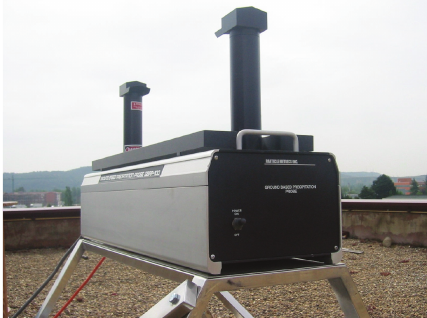
Figure 1: Ground-Based Precipitation Probe (PMI Model GBPP- 100) installed at the University of Le´on.